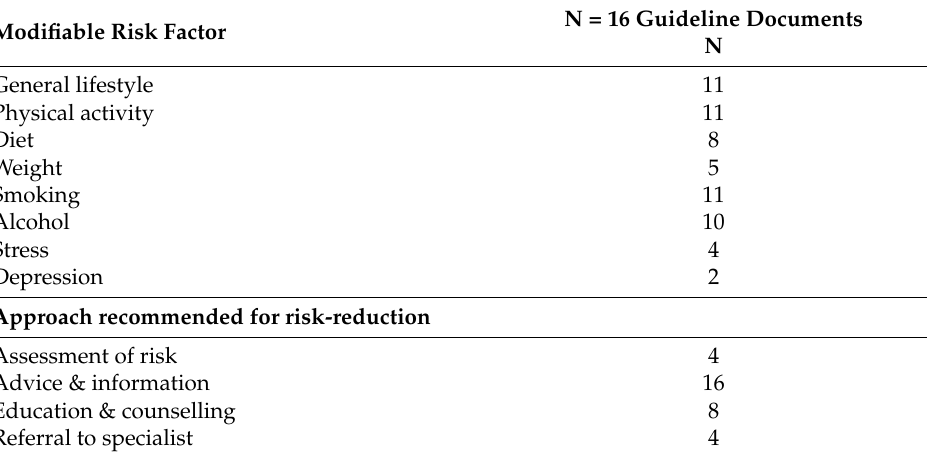
Table 3. Non-pharmacological, non-surgical stroke secondary prevention modifiable risk factors and approaches recommended in guideline documents.